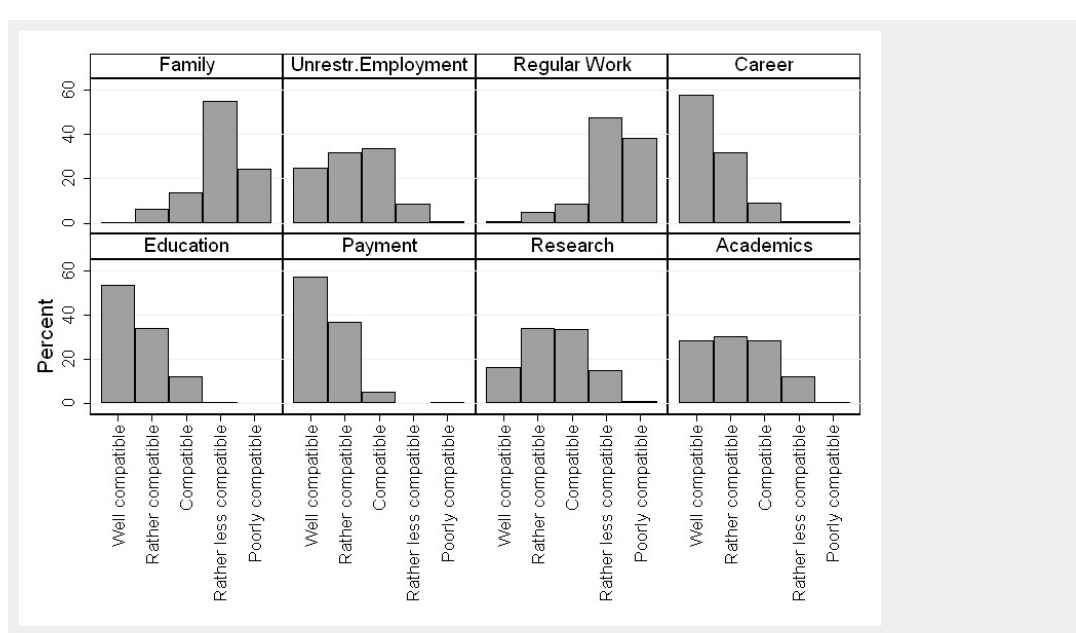
How compatible is surgery with the following aspects of the work environment: good work-life balance (family), unrestricted employment (unrest. employment), regular work, good career chances (career), optimal education (education), adequate payment (payment), possibility for research (research) and option for pursuing an academic career (academics)? Please assign a value to each option. (Answering options with five descriptors: well compatible – rather compatible – compatible – rather less compatible – poorly